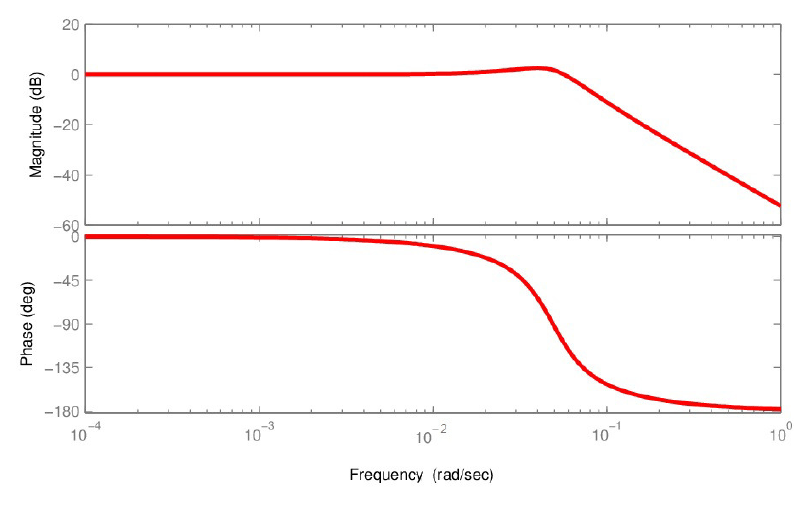
Figure 2. Bode plot of ∆ m out and ∆ m in in Equation